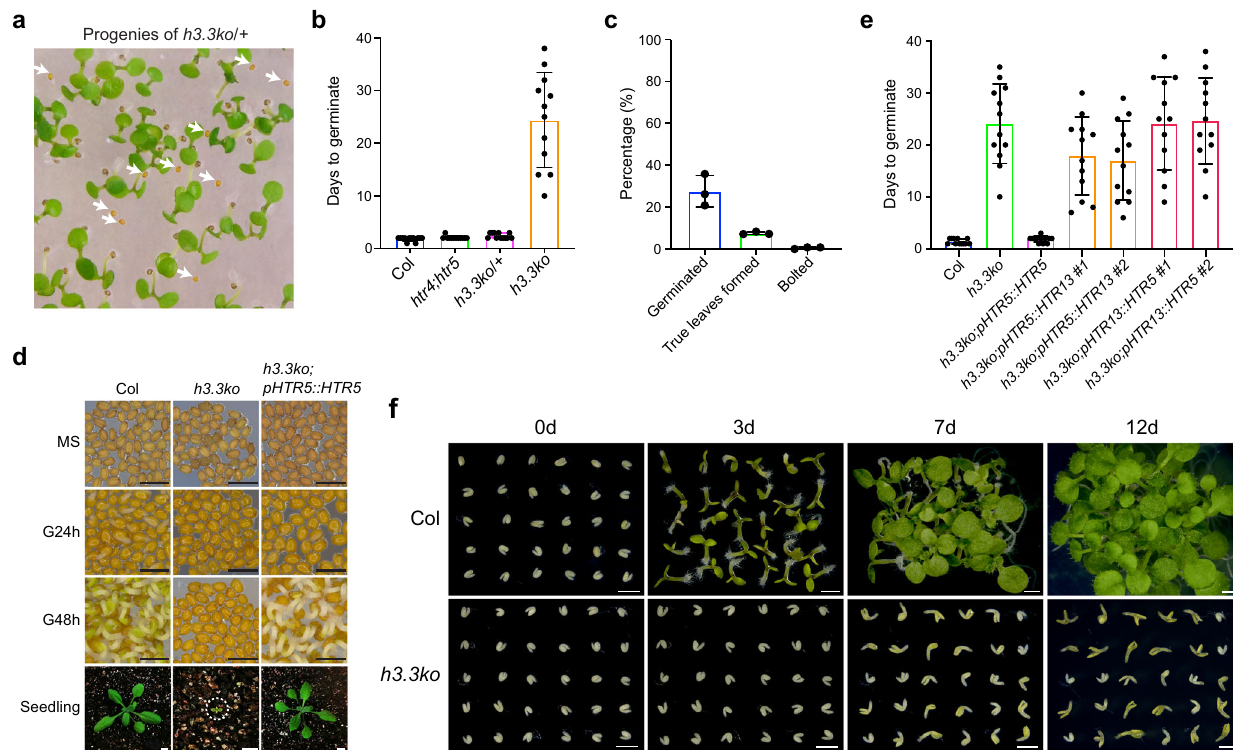
Fig. 1 | H3.3 is required for post-embryonic development. a The germination phenotype of h3.3ko/+ ( htr4/htr4;htr5/htr5;htr8/+ ) progenies. Arrows indicate h3.3ko seeds that are strongly delayed in germination. b Days to germinate of Col, htr4/htr4;htr5/htr5 , h3.3ko/+ ( htr4/htr4;htr5/htr5;htr8/+ ) and h3.3ko ( htr4/htr4;htr5/ htr5;htr8/htr8 ) seeds. Seeds collected from h3.3ko/+ plants were sown on 1/2 MS, theirgenotypesweredeterminedwithseedlingsformedaftergermination,andthe fi rst 12 germinated seeds were scored for each genotype. Values are means±SD. ( n =12 biologically independent seeds). Radicle protrusion was considered as the completion of seed germination. c Percentages of h3.3ko seeds that germinated (within two months), produced true leaves and bolted. Values are means±SD of three biological replicates. At least 110 seeds were used for each replicate. d The